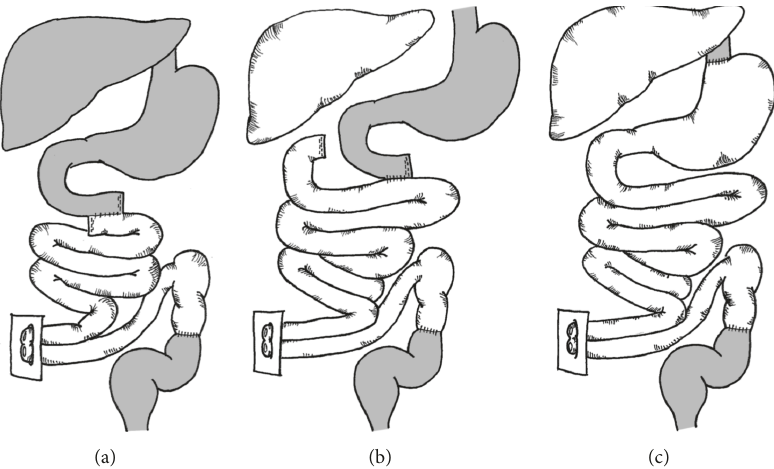
Figure 1: Types of allograft in intestinal transplantation. (a) Isolated intestine transplantation (IITx), (b) combined liver-intestine transplantation (L-ITx), and (c) multivisceral transplantation (MVTx). Note . Organs in grey represent native organs and dashed organs represent transplanted organs.